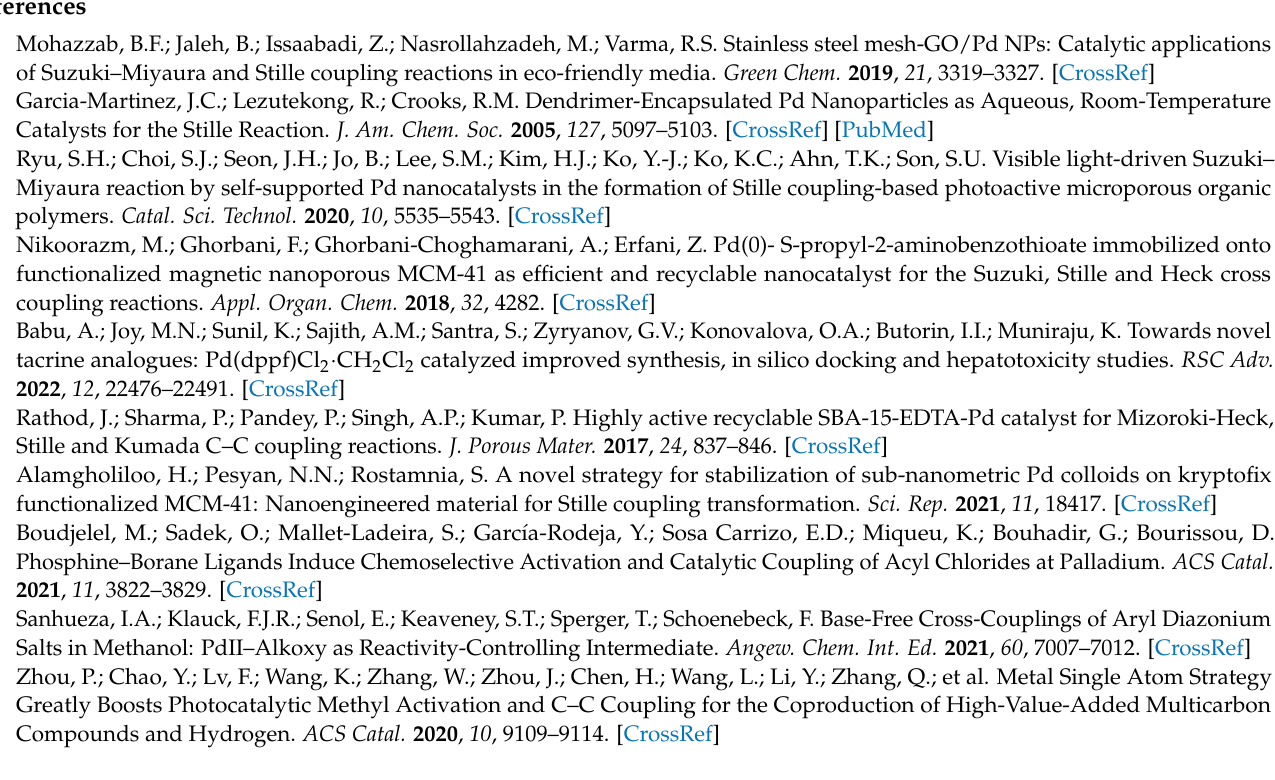
Figure S4: High-resolution FESEM images of (a) CPT-0.2, (b) CPT-1.5 and (c) CPT-2.0; Figure S5: High- resolution TEM images of (a,d) CPT-0.2, (b,e) CPT-1.0 and (c,f) CPT-2.0; Figure S6: The yield of styrene in the photocatalytic Stille reaction of Iodobenzene and Tributyl(vinyl)tin over different samples; Figure S7: Comparison of the activity of CPT-1.5 with those of previously reported photocatalysts for photocatalyzed stille reactons; Figure S8: XRD of CPT-1.5 before and after repeated test in photocatalytic Stille reaction; Figure S9: TEM of CPT-1.5 after repeated test in photocatalytic Stille reaction; Figure S10:Pd 3d XPS spectra of CPT-1.5 after repeated test in photocatalytic Stille reaction; Figure S11: FI-IR of tributylvinyltin over in different catalysts during the photocatalytic Stille reaction; Figure S12: UV-Vis DRS of PT, CPT-1.5 and CPT-2.0; Figure S13: The plots of transformed Kubelka- Munk function versus the energy of light; Figure S14: Transient photocurrent response of PT, CPT-1.5 and CPT-2.0; Figure S15: EIS Nyquist plots of PT, CPT-1.5 and CPT-2.0; Figure S16: PL curves of PT, CPT-1.5 and CPT-2.0; Table S1: Structural parameters of different samples; Table S2: Content of CuPd for different